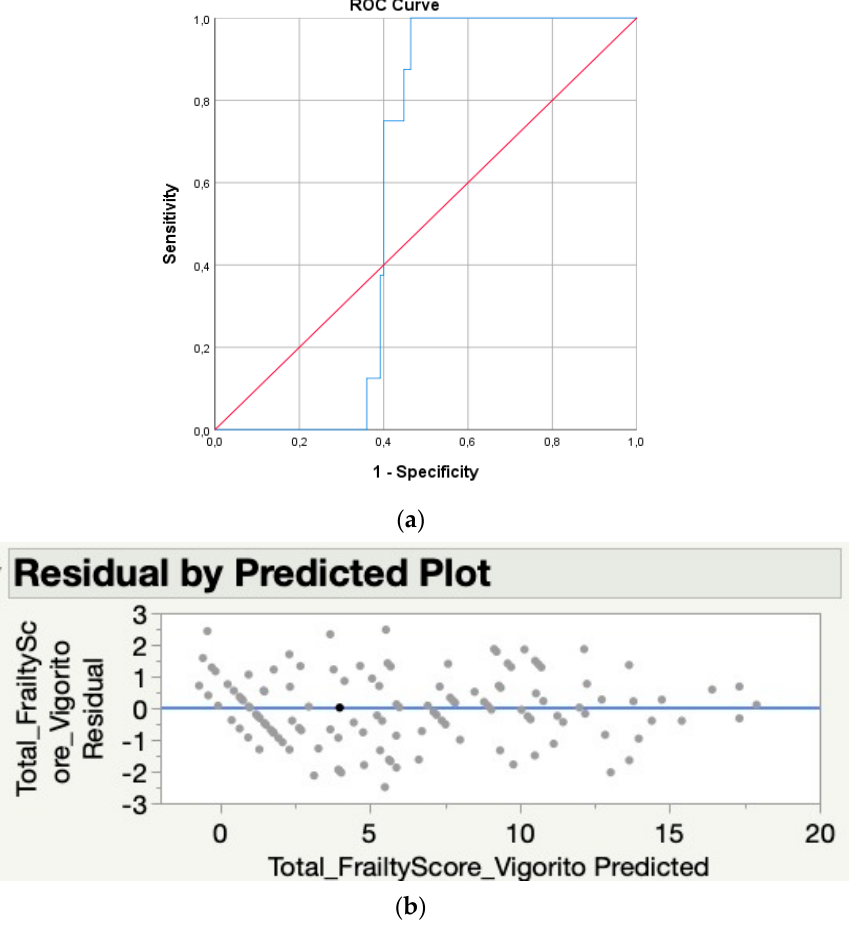
Figure 2. ROC curve ( a ) and plot ( b ) of the new regression formula vs. the total frailty score of Vigorito et al.